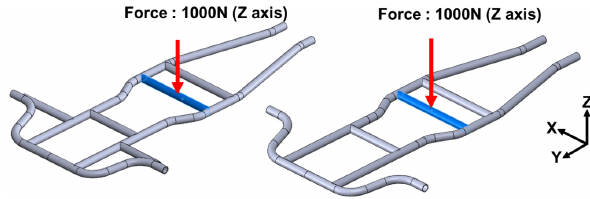
Figure 19. Frame (with/without stiffeners) – application end.